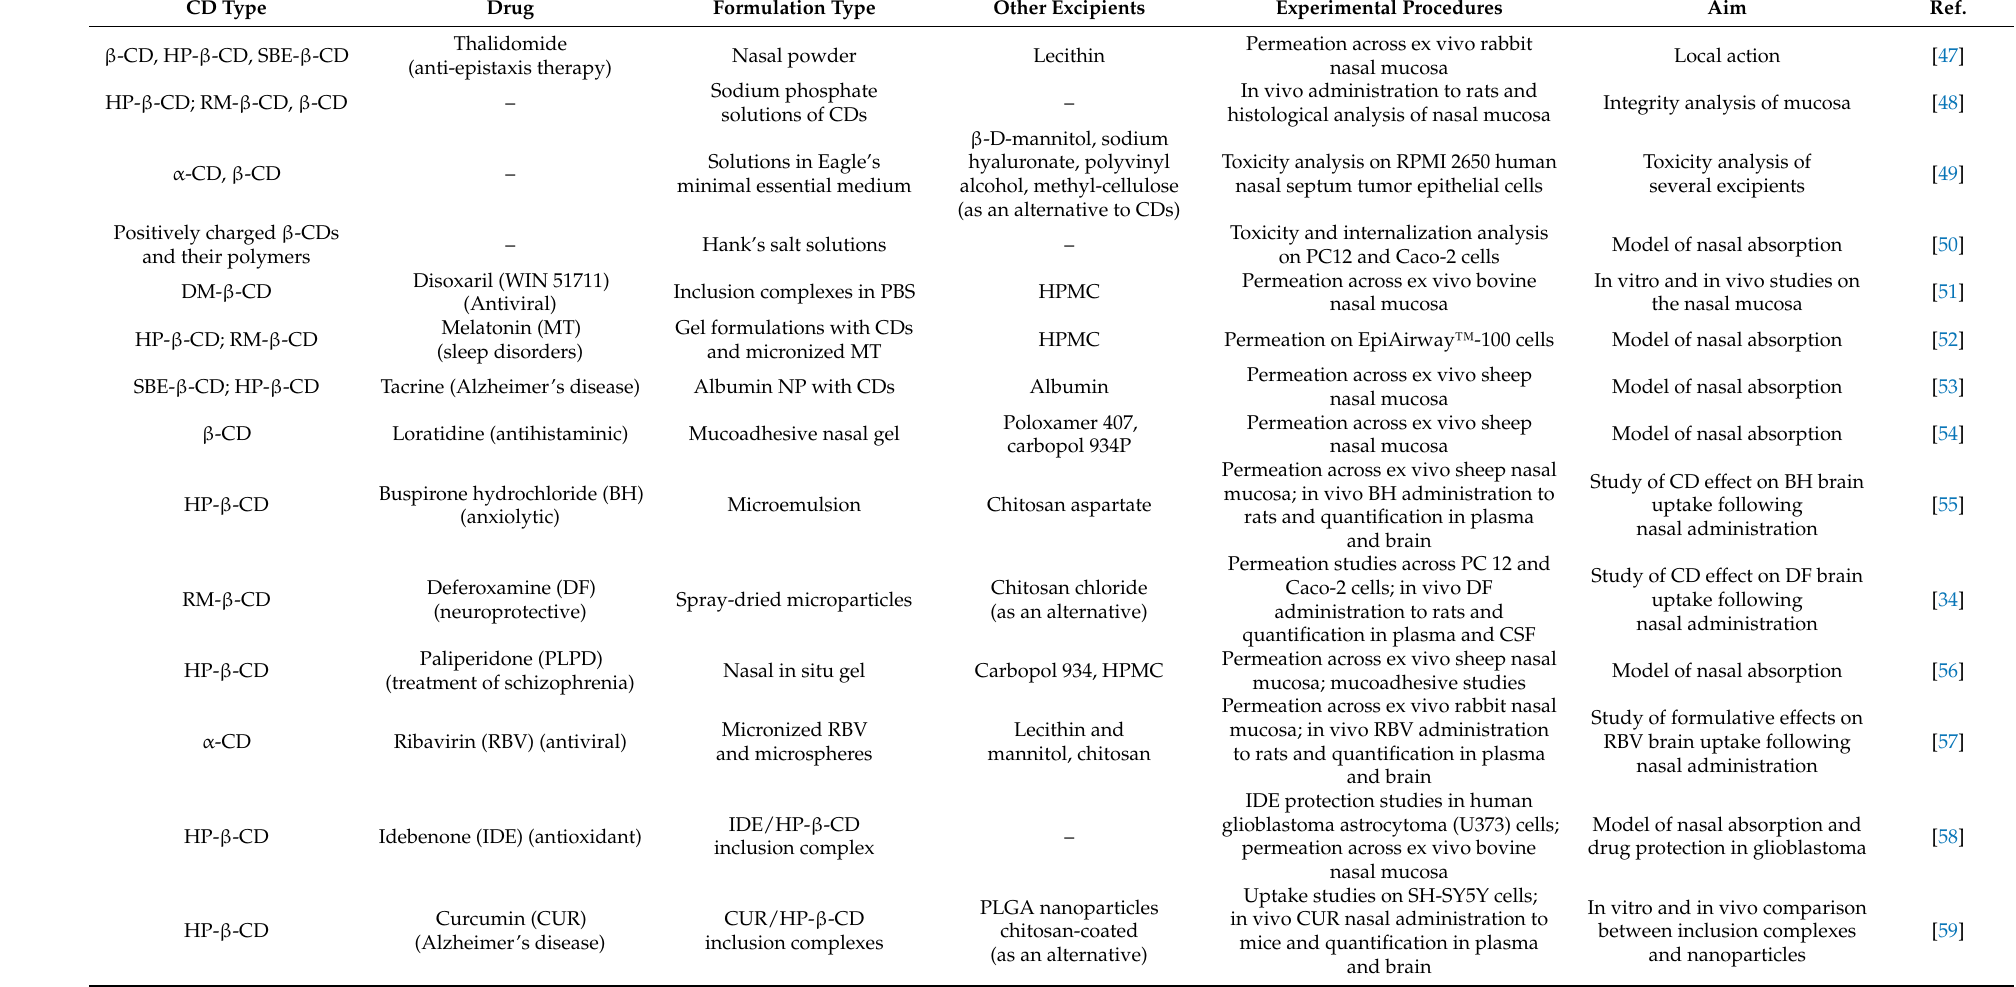
Table 1. Formulations containing CDs designed for nasal administration as described in Section